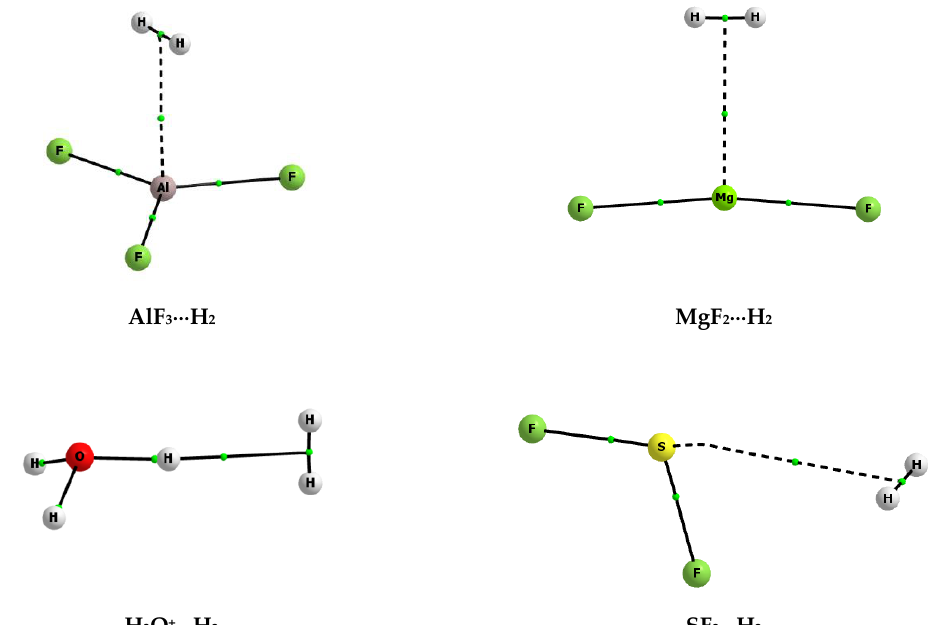
Figure 1. The molecular graphs of selected complexes analysed here; big circles correspond to attractors, small green circles to bond critical points, and continuous and broken lines to bond paths.